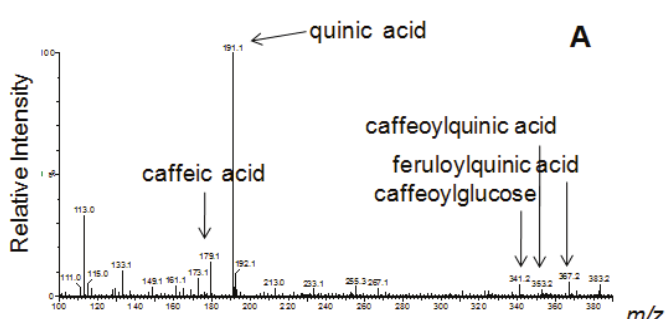
FIGURE 1 - ESI(-)-MS of mate tea ( Ilex paraguariensis ).